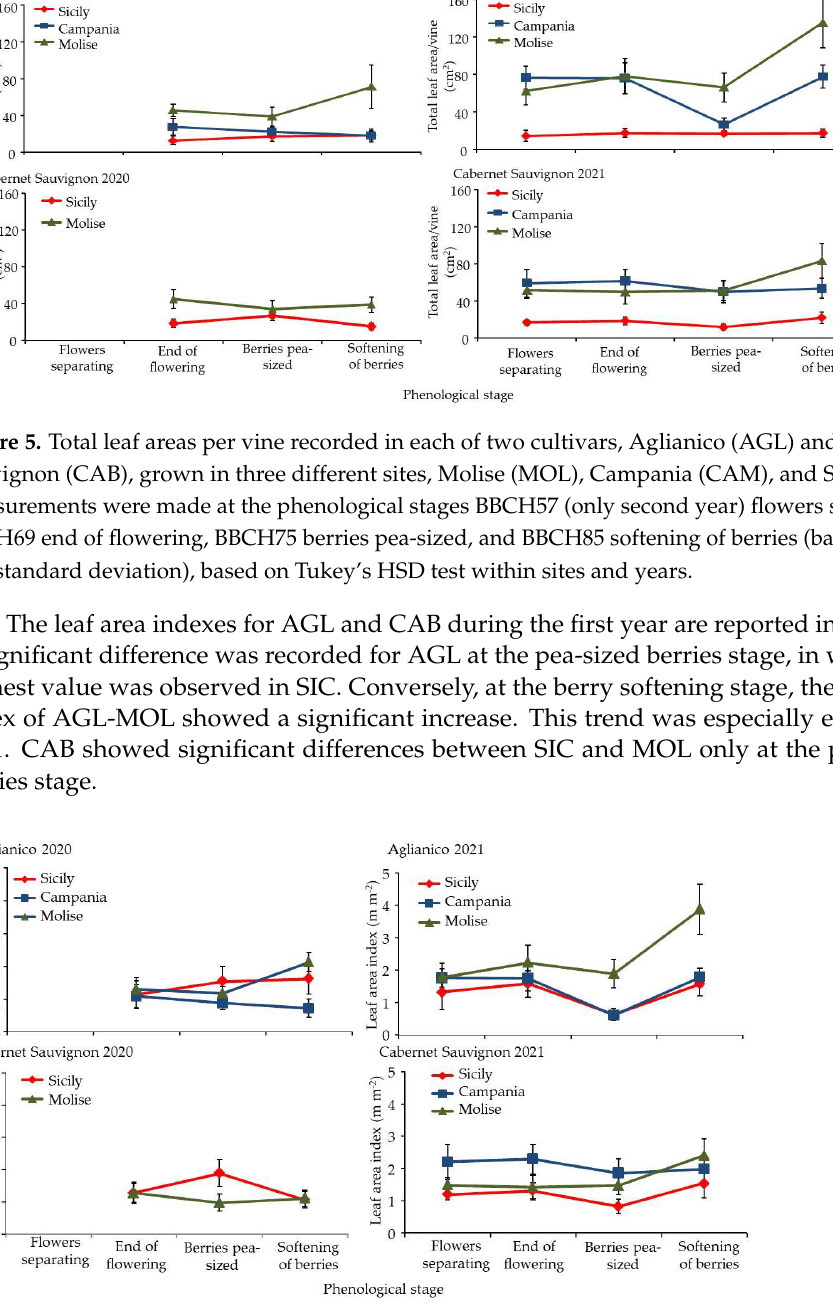
Figure 4. Leaf areas from the main and lateral shoots in each of two cultivars, Aglianico (AGL) and Cabernet Sauvignon (CAB), grown at three different sites, Molise (MOL), Campania (CAM), and Sicily (SIC). Measurements were made at the phenological stages BBCH57 (only second year) flowers separating, BBCH69 end of flowering, BBCH75 berries pea-sized, and BBCH85 softening of berries (bars indicate one standard deviation), based on Tukey’s HSD test within sites and years. Concerning the total leaf area per vine (Figure 5), AGL in MOL, during the first year at each phonological stage, showed significantly higher values. During the second year, except at the pea-sized berries stage, the vine behaviour was similar between CAM and MOL. In SIC, no differences were recorded between the different stages. For CAB, the trends for total leaf area per vine were similar to those for AGL.